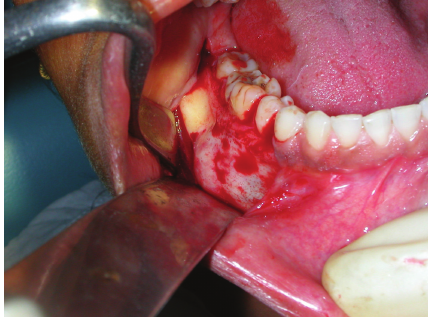
Figure 1: Intraoral view shows slight expansion of the buccal cortex in the region of mandibular first molar on right side.